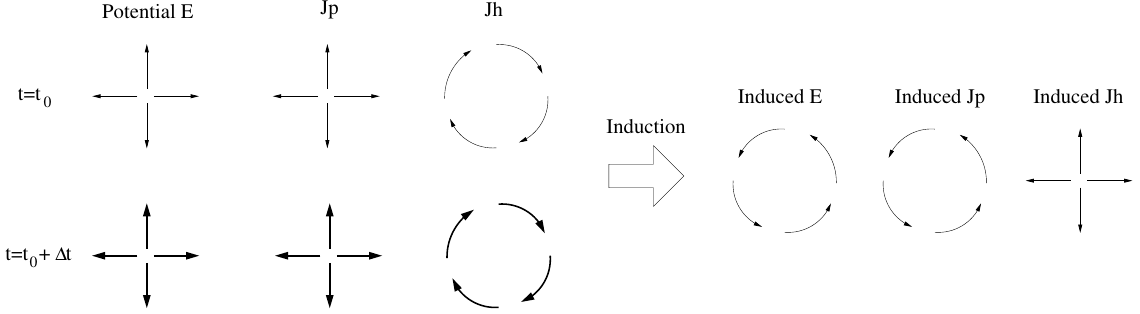
Fig. 12. Lenz’s law in ionospheric electrodynamics (assuming uniform conductances and downward pointing background magnetic field). Changes in the potential electric field and associated currents ( J P and J H ) create rotational induced electric field. Direction of induced E is such that induced Pedersen currents oppose the change in rotational currents. This means that the induced Hall currents enhance the change in divergent currents and associated FAC. In the case of non-uniform ionospheric conductances the situation is more complicated.